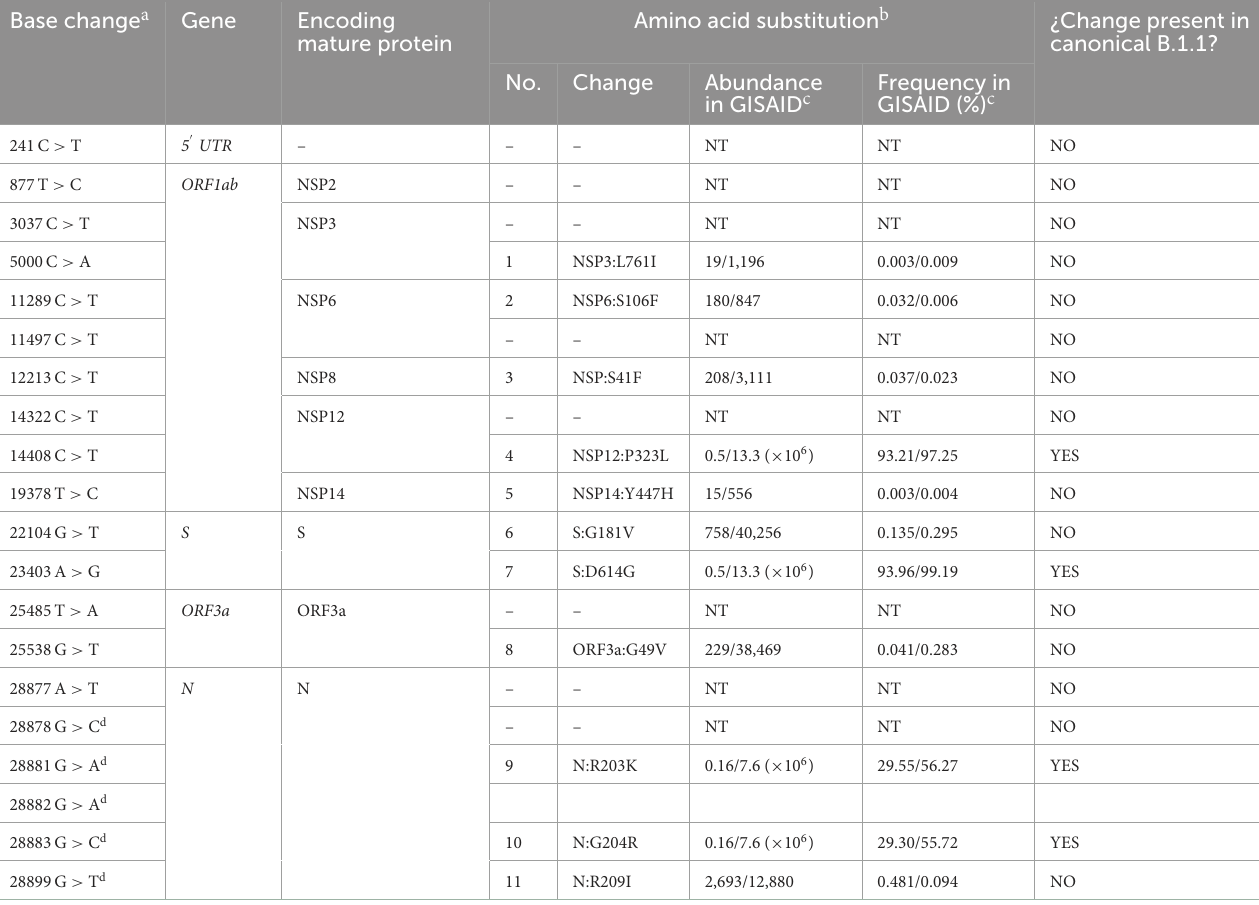
TABLE 2 Base substitutions found by NGS of the viral genome, and corresponding amino acid substitutions, indicating the abundance and frequency of each amino acid change among the genome sequences deposited in the GISAID database on December 4, 2020 and, after the slash, on November 2, 2022. Base change